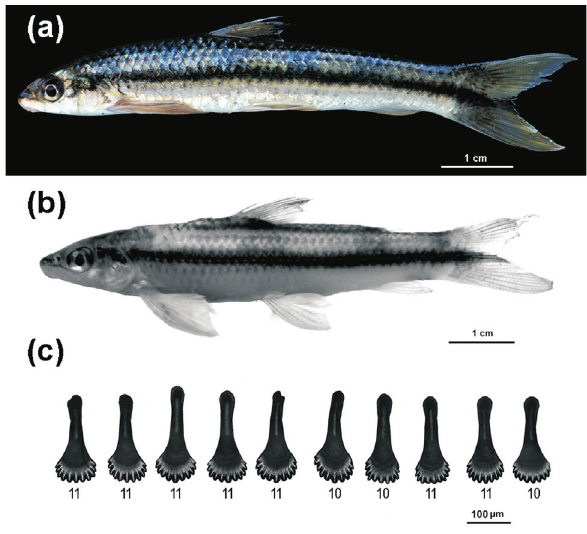
Figure 1 - Photograph of the Apareiodon sp. from the Aripuanã River: In (a) coloured image showing a regular black longitudinal stripe extending from head to tail; the fins have a yellowish tone (pectoral, dorsal, caudal) and the end of the black stripe; In (b) black and white image showing de- tailsofthefins.In(c)symphesialteethimagesshowingthetoothmorphol- ogyandcuspsnumber.Thenumberineachtoothisthenumberofcusps.